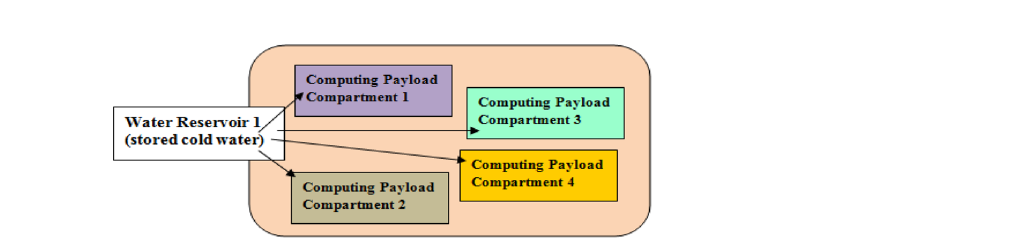
Figure 3. Underwater Data Center with four computing payload compartments and one water reservoir.